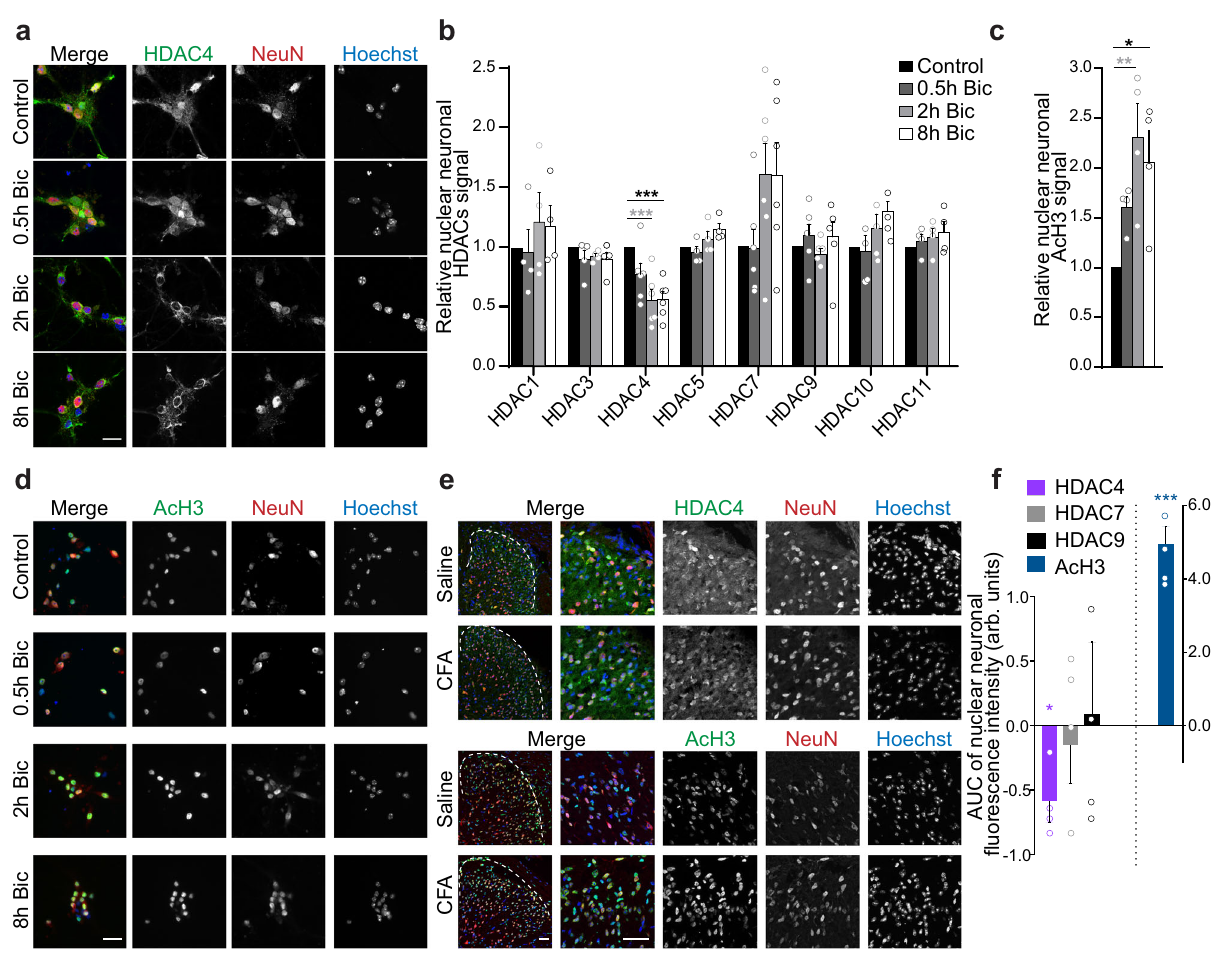
Fig. 1 Neuronal activity and persistent in fl ammatory nociception trigger the nuclear export of HDAC4 and histone 3 acetylation in spinal cord neurons. a Representative images of cultured primary spinal cord neurons (DIV10) immunostained for endogenous HDAC4 (green) and the neuronal marker NeuN (red); Hoechst (blue) marks the nuclei. Scale bar is 20 µ m. b Quanti fi cation of the relative fl uorescence intensity of the nuclear HDACs signal in spinal cord neurons normalized to respective controls. Each point represents the mean value derived from one independent experiment. Ca. 40 cells were analyzed per condition and experiment (HDAC1 n = 4 F (3,8) = 1.120; HDAC3 n = 4 F (3,12) = 0.9239; HDAC4 n = 6 F (3,20) = 8.676; HDAC5 n = 4 F (3,12) = 3.210; HDAC7 n = 6 F (3,20) = 2.726; HDAC9 n = 5 F (3,20) = 0.7916; HDAC10 n = 4 F (3,8) = 2.502; HDAC11 n = 4 F (3,12) = 0.6623). c Quanti fi cation of the relative fl uorescence intensity of the nuclear signal of acetylated histone H3-Lys9 (AcH3) in spinal cord neurons, treated as indicated. Ca. 30 cells were analyzed per sample ( n = 4 F (3,12) = 5.854). d Representative images of primary cultured spinal cord neurons (DIV10) immunostained for AcH3 (green). Cells were treated with Bic (50 µ M) for the indicated times. Nuclei were labelled with Hoechst (blue) and NeuN (red) as a neuronal marker. Scale bar is 40 µ m. e Representative images of spinal cord dorsal horn sections of lumbar spinal segments L3 – 5 of mice 24 h after intraplantar CFA or saline injection, immunostained for HDAC4 or acetylated histone H3-Lys9 (AcH3) shown in green; NeuN (red). Nuclei were labeled with Hoechst (blue) and scale bar is 40 µ m. Higher magni fi cations of the upper laminae are shown in the right panels with a scale bar of 40 µ m. f Quanti fi cations of the average nuclear fl uorescence intensities from immunolabeled HDACs and AcH3 in neurons of the spinal cord dorsal horn, normalized to values obtained from saline- injected mice and integrated over a time course series ( n = 4 mice per condition and timepoint). Timepoints used were 0.5, 2, 6, and 24 h. Statistically signi fi cant differences were determined by one-way ANOVA followed by Dunnett ’ s post hoc test ( b , c ) or two-tailed Student ’ s t- test ( f ). *** p < 0.001; ** p < 0.01; * p < 0.05. In bar graphs, each point represents a value derived from one independent culture or mouse. Graphs represent mean ± SEM. See also Supplementary Figs. 1 and 2. 2 h, 6 h, and 24 h) post-CFA or saline injection and calculated the neurons took place preferentially in laminae I-II (Supplementary variations over time from the saline-baseline. We observed a Fig. 2g). Nuclear levels of HDAC4 in the ipsilateral dorsal spinal reduction of the nuclear HDAC4 content in dorsal horn neurons cord of mice subjected to the spared nerve injury (SNI) model of of in fl amed mice relative to saline-treated mice (Fig. 1e, f; Sup- neuropathic pain did not change relative to the contralateral side plementary Fig. 2e – g). Consistent with our observations in cul- (Supplementary Fig. 2i), suggesting that HDAC4 nuclear exclu- tured spinal cord neurons, the nociceptive input-triggered sion might be modulated differentially in distinct pain states. As subcellular redistribution of HDACs appeared to be speci fi c for expected, c-Fos levels and the number of c-Fos positive cells in HDAC4 as the nuclear content of other class IIa HDACs the dorsal horn were signi fi cantly elevated 2 h after intraplantar (HDAC7 and -9) was not affected (Fig. 1f, Supplementary Fig. 2g, CFA injections (Supplementary Fig. 2j – m) 6,27 . NF-kB is a tran- scription factor that regulates numerous in fl ammatory h). Differential analysis between super fi cial and deeper laminae responses 28 . Expression of IkB α , an inhibitor of NF-kB that binds revealed that the reduction of nuclear HDAC4 in dorsal horn NATURE COMMUNICATIONS| (2022) 13:875